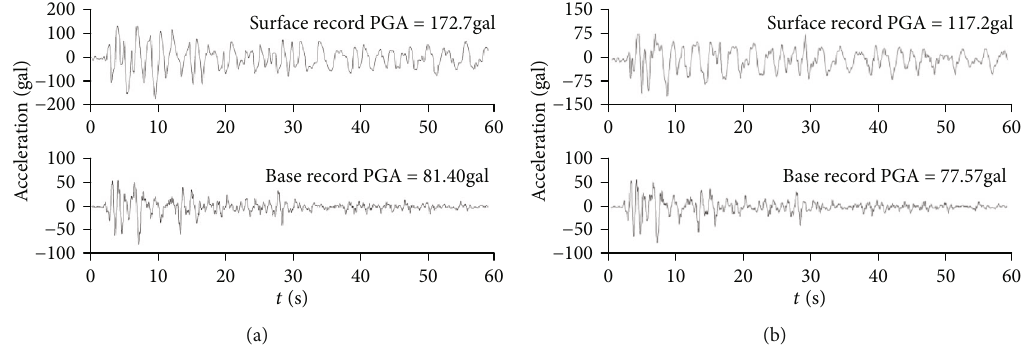
Figure 3: Acceleration time history response of EL – 2 situation: (a) model 1 and (b) model